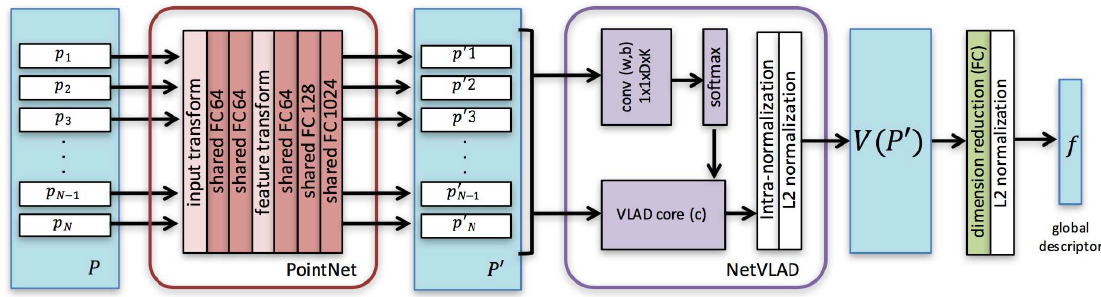
Figure 2. Network architecture of PointNetVLAD (Angelina, Hee Lee,